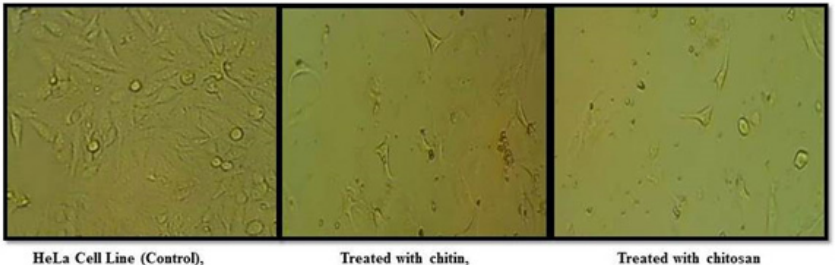
Fig. 11. Control Cell Line and the Cell Line treated with chitin and chitosan sample - microscopic Table 1. Zone of inhibition in mm for antimicrobial